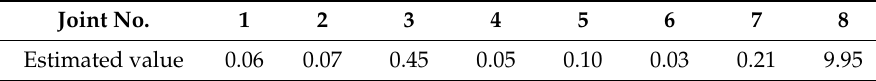
(cid:2) 10 6 Nm/rad